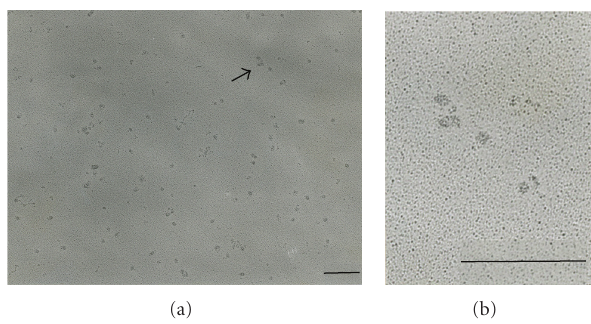
Figure 4: Rotary shadowed images of purified nebulin from rabbit back muscle. (a) typical images of nebulin molecules. (b), enlarged images of arrow at (a). Bar, 200 nm.